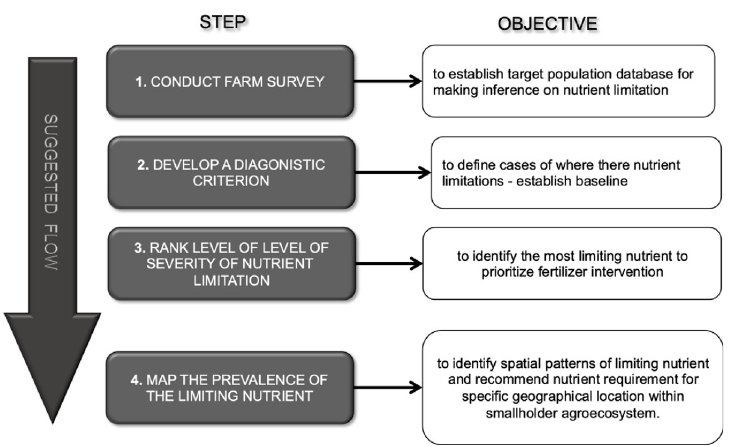
Fig 2. Sequence of step used for implementing a population-based farm survey for nutrient diagnostics of maize fields within smallholder agroecosystem.